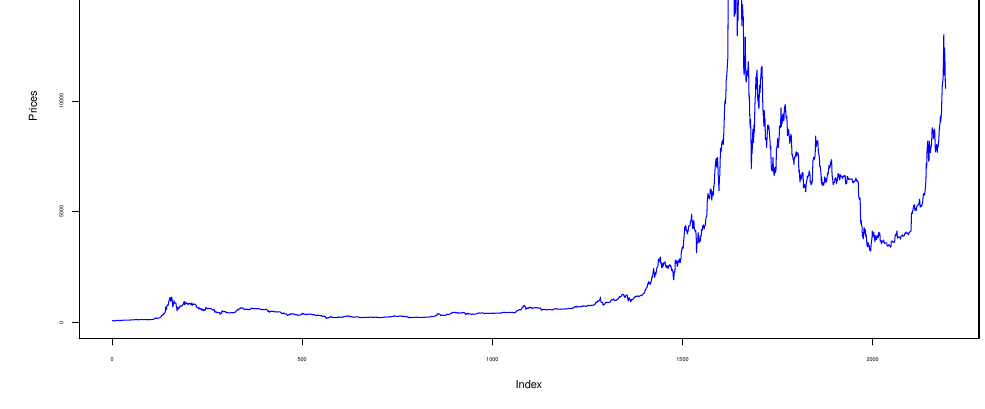
Figure 3. Bitcoin asset prices.